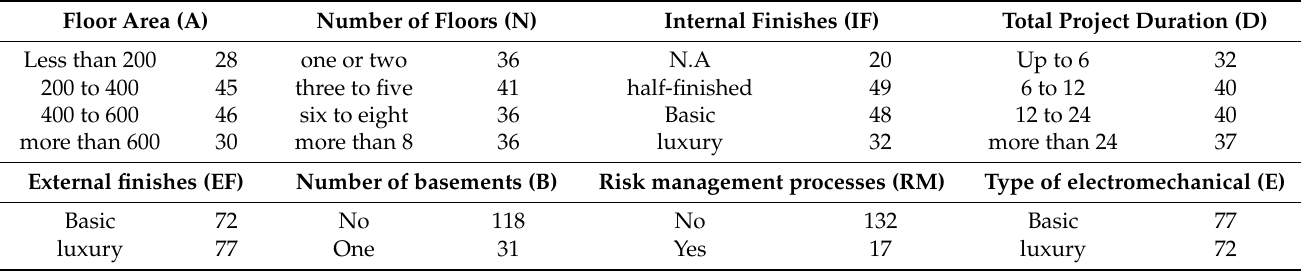
Table 7. Demographic data of